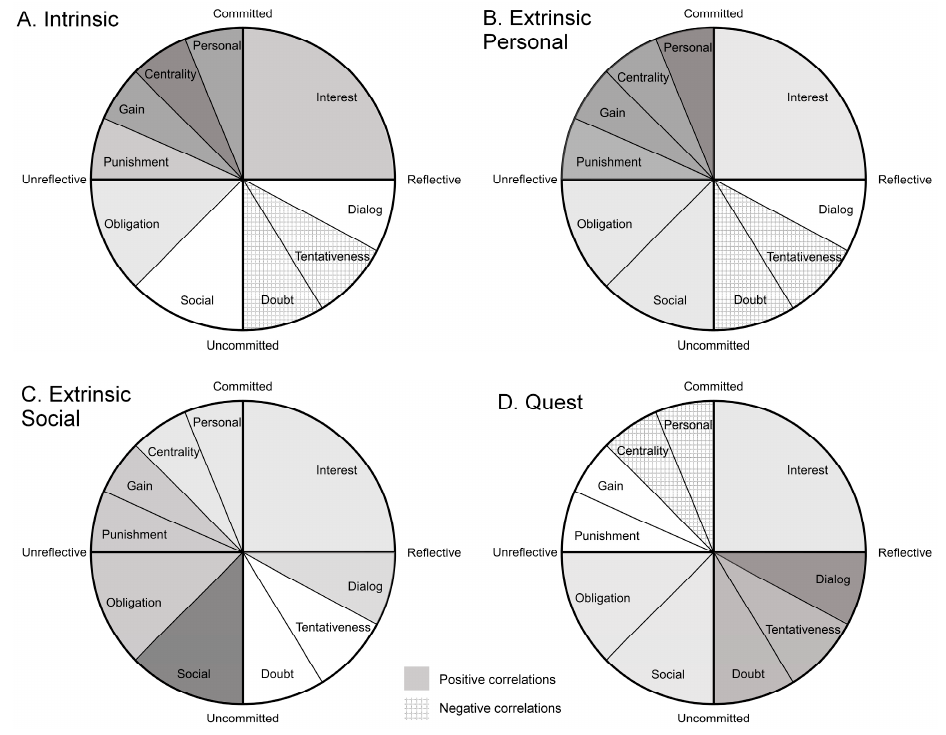
Figure 4. Above is an illustration of the established models (I/E–Revised and Quest), and how the correlations with the CROI overlap. Darker colors represent stronger